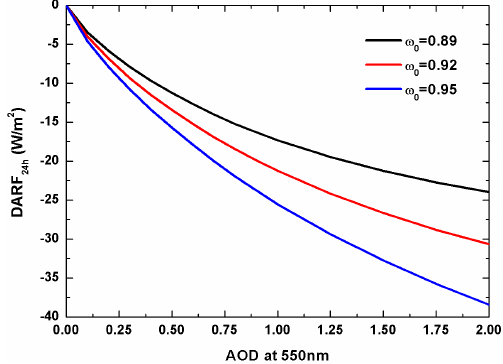
Figure 9. Direct radiative forcing of biomass burning aerosols (24h- DARF) over the forest as a function of aerosol optical depth (AOD) at 550nm and single-scattering albedo ( ω 0 ) at 440nm according to radiative transfer